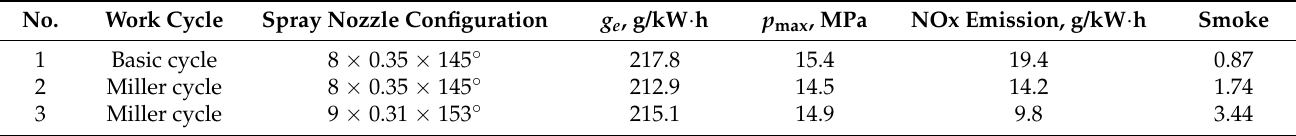
Table 3. Test results of a diesel engine (21/21) with different work cycles and nozzle atomizer designs. No. Work Cycle Spray Nozzle